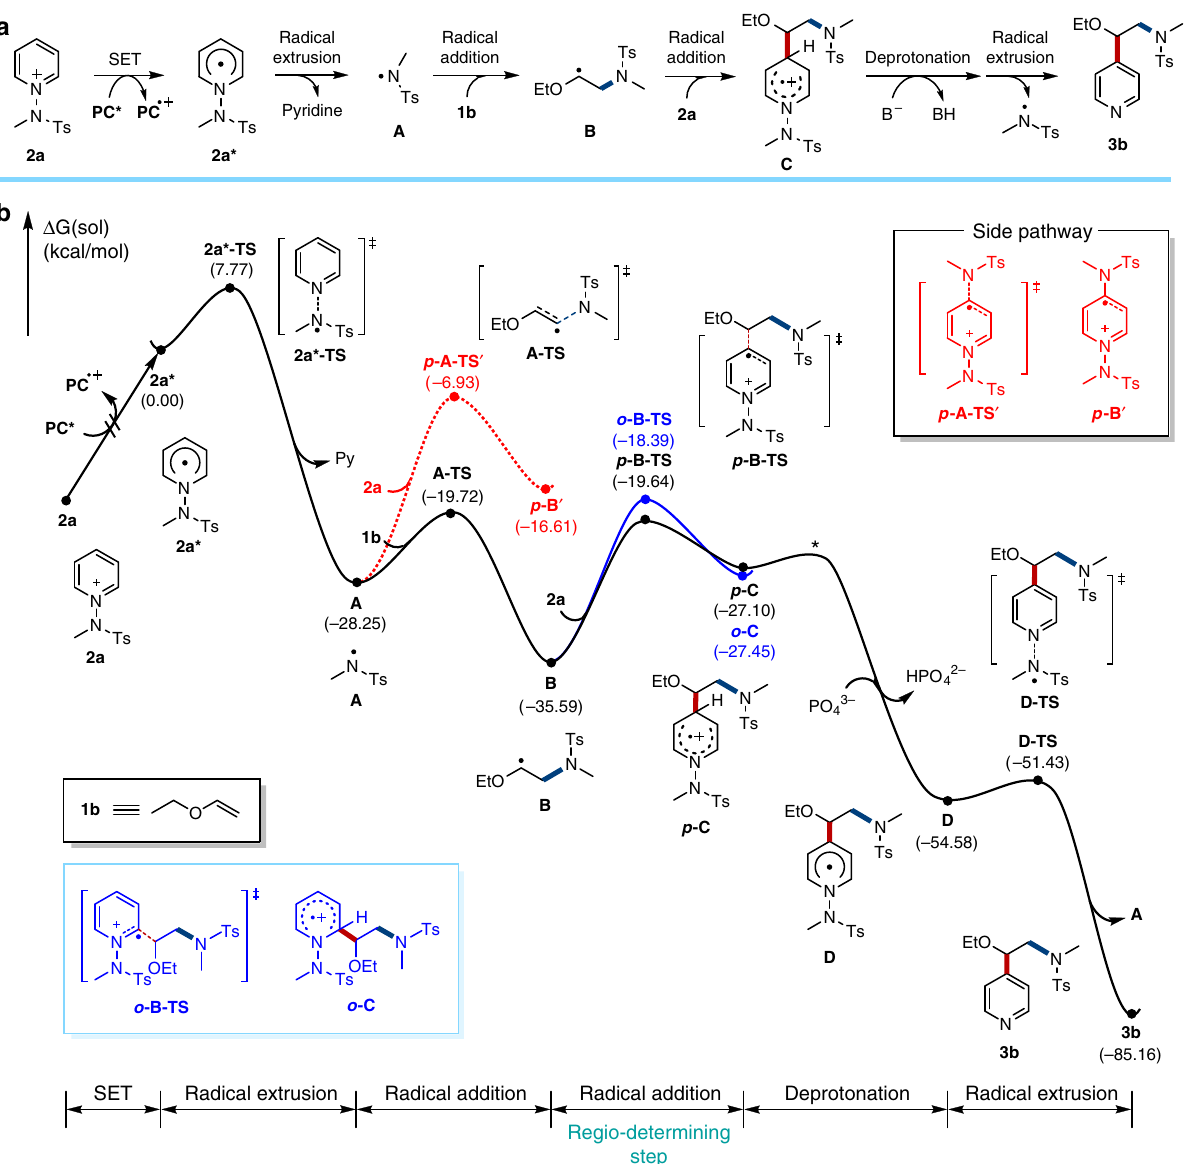
Fig. 2 Propose reaction pathway and related free energy pro fi le. a Proposed reaction pathway. b Free energy pro fi le for the formation of 3b that is described with a solid black line. Blue and red traces represent the side pathway toward ortho (C2)-product generation and direct N radical attack on 2a , respectively. Energy pro fi le for ortho (C2)-product is only shown in a radical addition step as it has a very similar energy trend with that of p -B ’ after radical addition